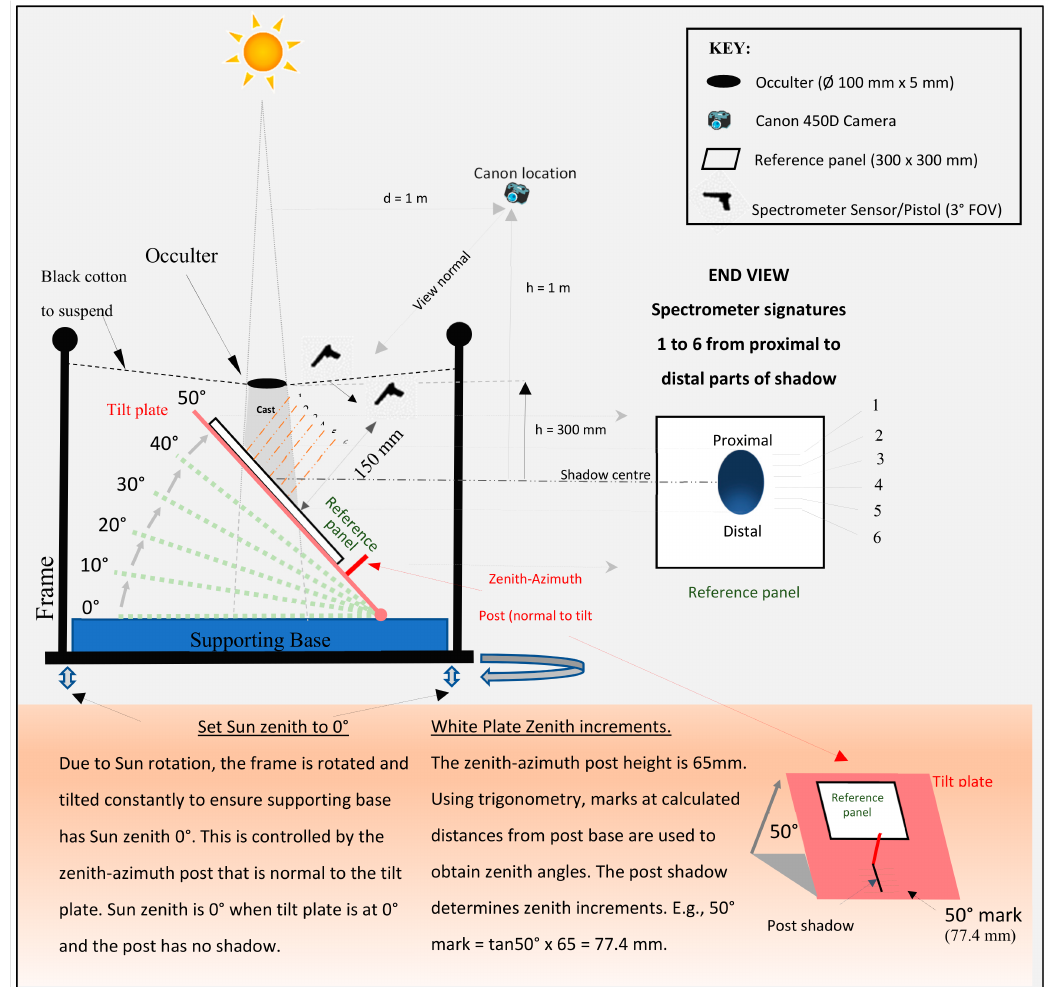
Figure 3. Occulter used to simulate cast shadow on material plate at six zenith angles; 0 ◦ , 10 ◦ , 20 ◦ , 30 ◦ , 40 ◦ , and 50 ◦ . Example above is at 50 ◦ zenith. Supporting base maintained at 0 ◦ Sun zenith and azimuth so that the tilt plate (with reference panel attached) can be adjusted to incremental zenith angles using a zenith-azimuth post. For each zenith angle, a Canon photo is acquired, plus six equal-spaced FR spectroradiometer measurements are taken longitudinally along shadow footprint from proximal to distal at a distance of 150 mm. A zenith / azimuth post is used to calibrate zenith and azimuth angles. For every plate zenith, the occulter is adjusted to be 300 mm above shadow